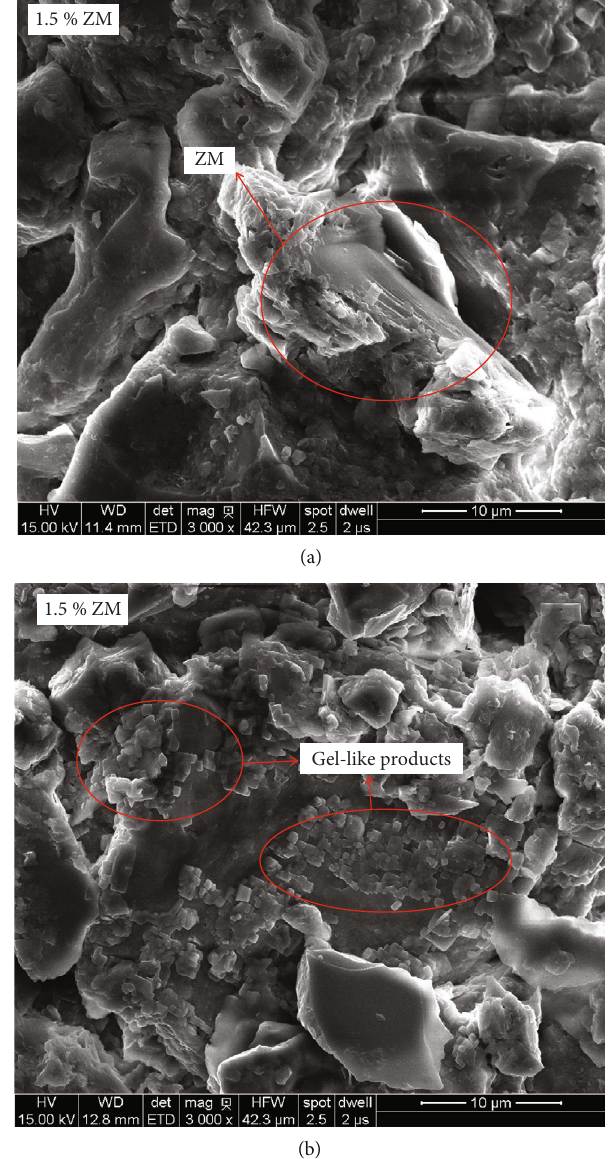
Figure 10: SEM images of saline soils modi fi ed with 1.5% ZM after (a) 7d and (b) 28d of